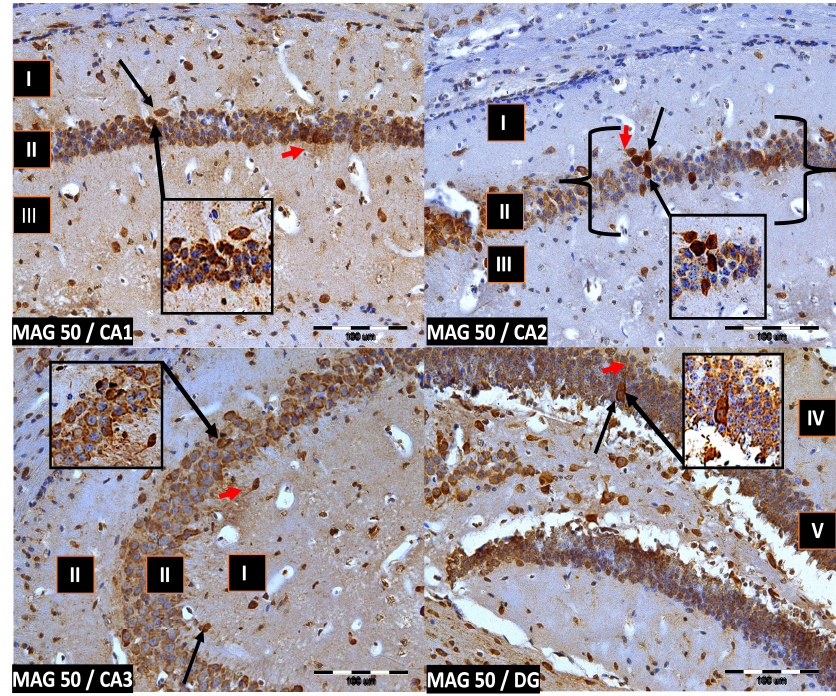
Figure 4. Group MAG20. Immunoreactivity of PV-IR neurons in the fields CA1–CA3 and the DG of the mouse hippocampus was observed. I. the marginal layer, II. the pyramidal layer, III. the multiform layer, IV. the molecular layer, V. the granular layer. The arrows indicate PV-IR neurons (black arrow) and PV-IR nerve fibers (red arrow) in the hippocampus. Magnification × 20.